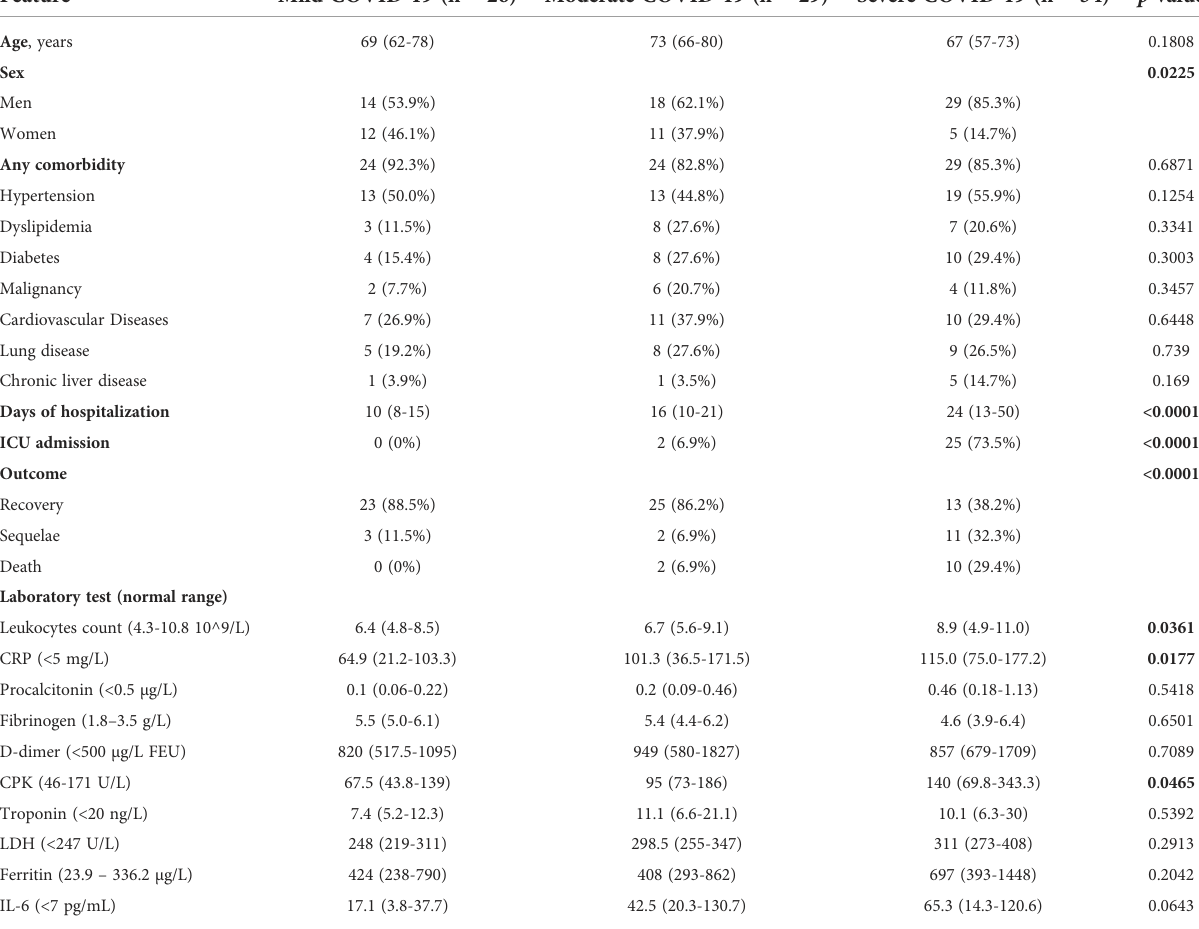
TABLE 1 Demographics data, clinical characteristics and laboratory fi ndings in patients with SARS-CoV-2 infection at the time of hospital admission (n = 89).